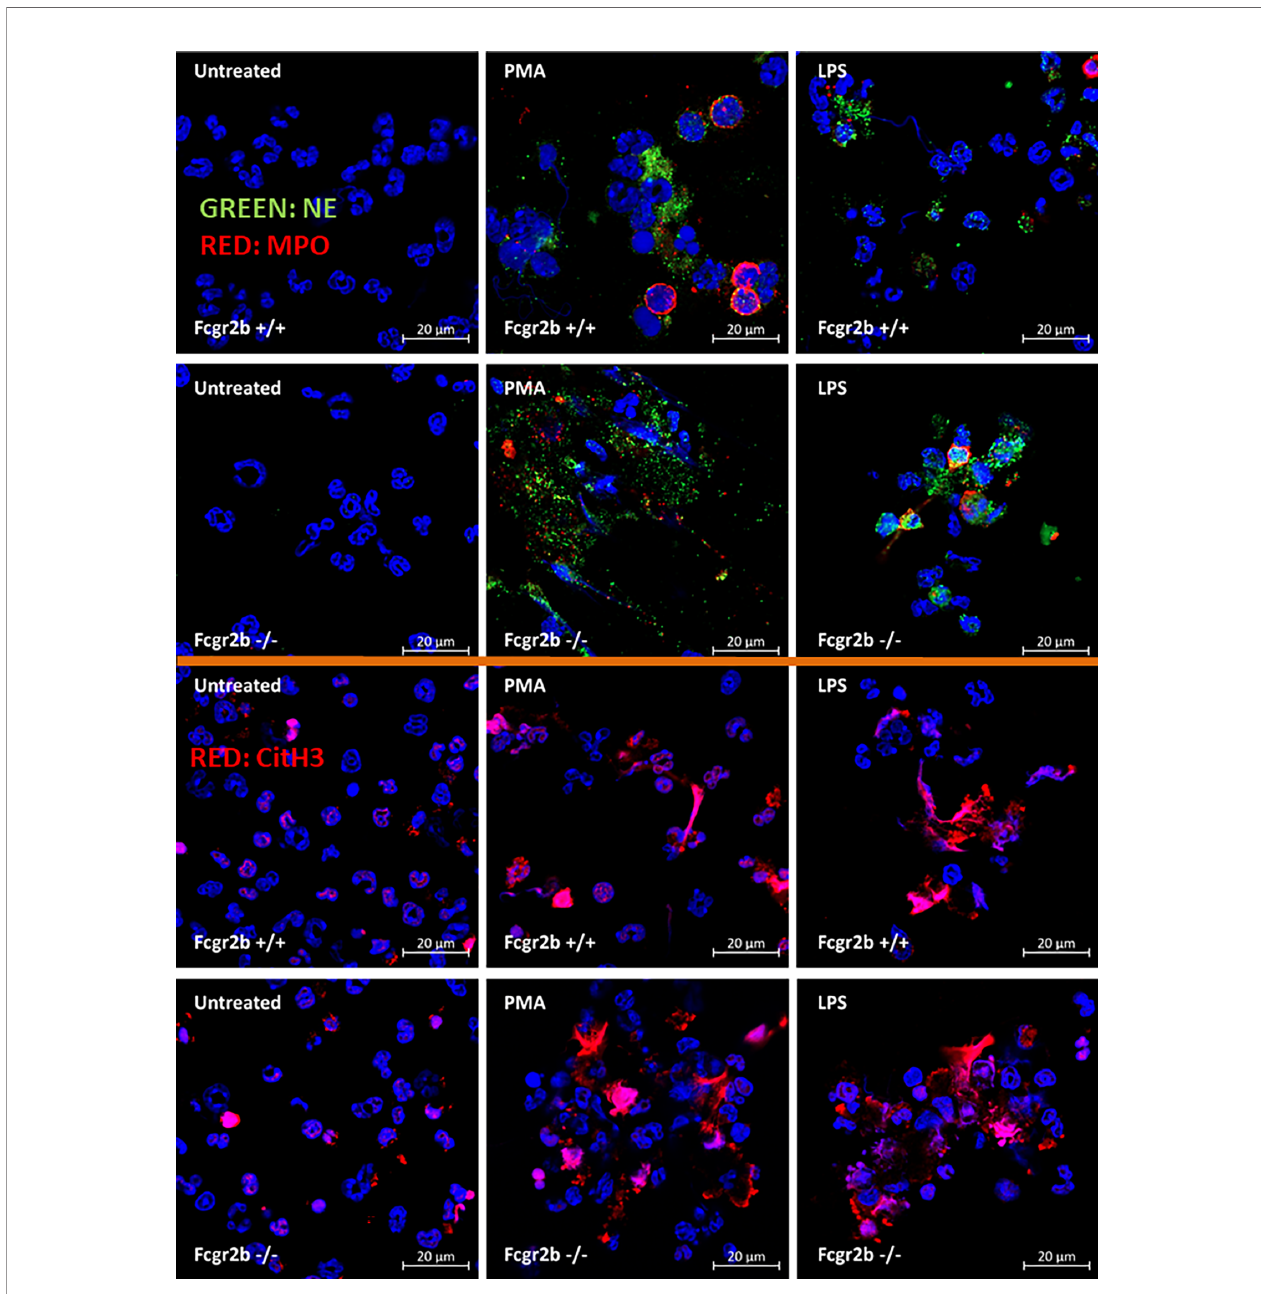
FIGURE 7 | Prominent neutrophil extracellular traps (NETs) at 4 h of the stimulation in neutrophils of lupus prone mice. The representative immuno fl uorescent pictures of NETs formation in Fcgr2b-/- and wild-type (Fcgr2b+/+) neutrophils after 4 h activation by phorbol myristate acetate (PMA), a NETs activator, or lipopolysaccharide (LPS), a TLR-4 stimulator, as evaluated by the co-staining of myeloperoxidases (MPO) and neutrophil elastase (NE) (upper part) or citrullinated histone H3 (CitH3) (lower part) are